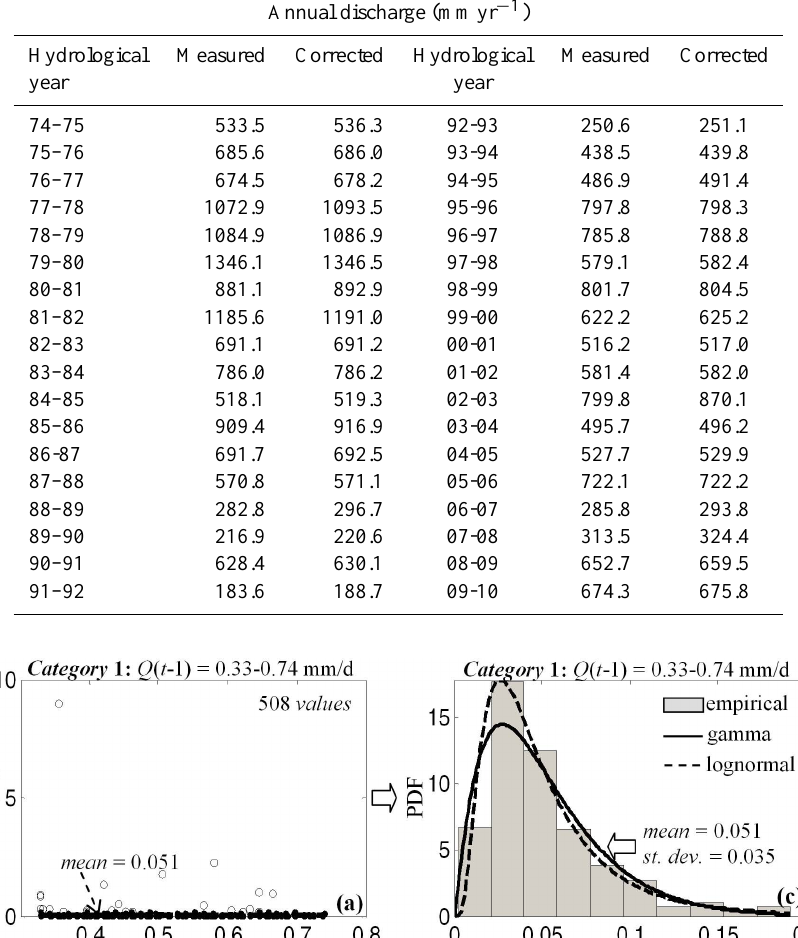
Table 6. Annual discharges, per unit area of the basin, for the original and corrected runoff series for the period 1 October 1974 to 30 September 2010.